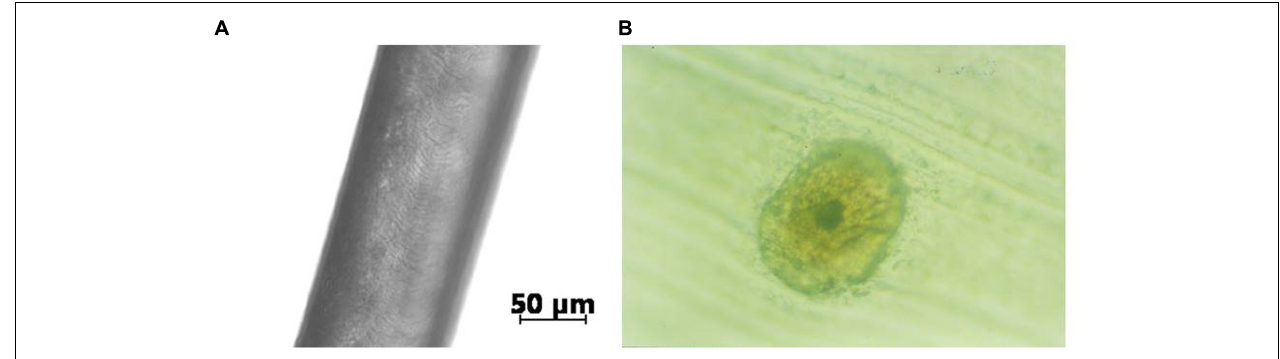
FIGURE 1 | An example of ape hair (from orangutan) view in a microscope, Amaral (2008). The external appearance with the cuticle scale structure is shown in panel (A) and the cross-section inner structure in panel (B) .